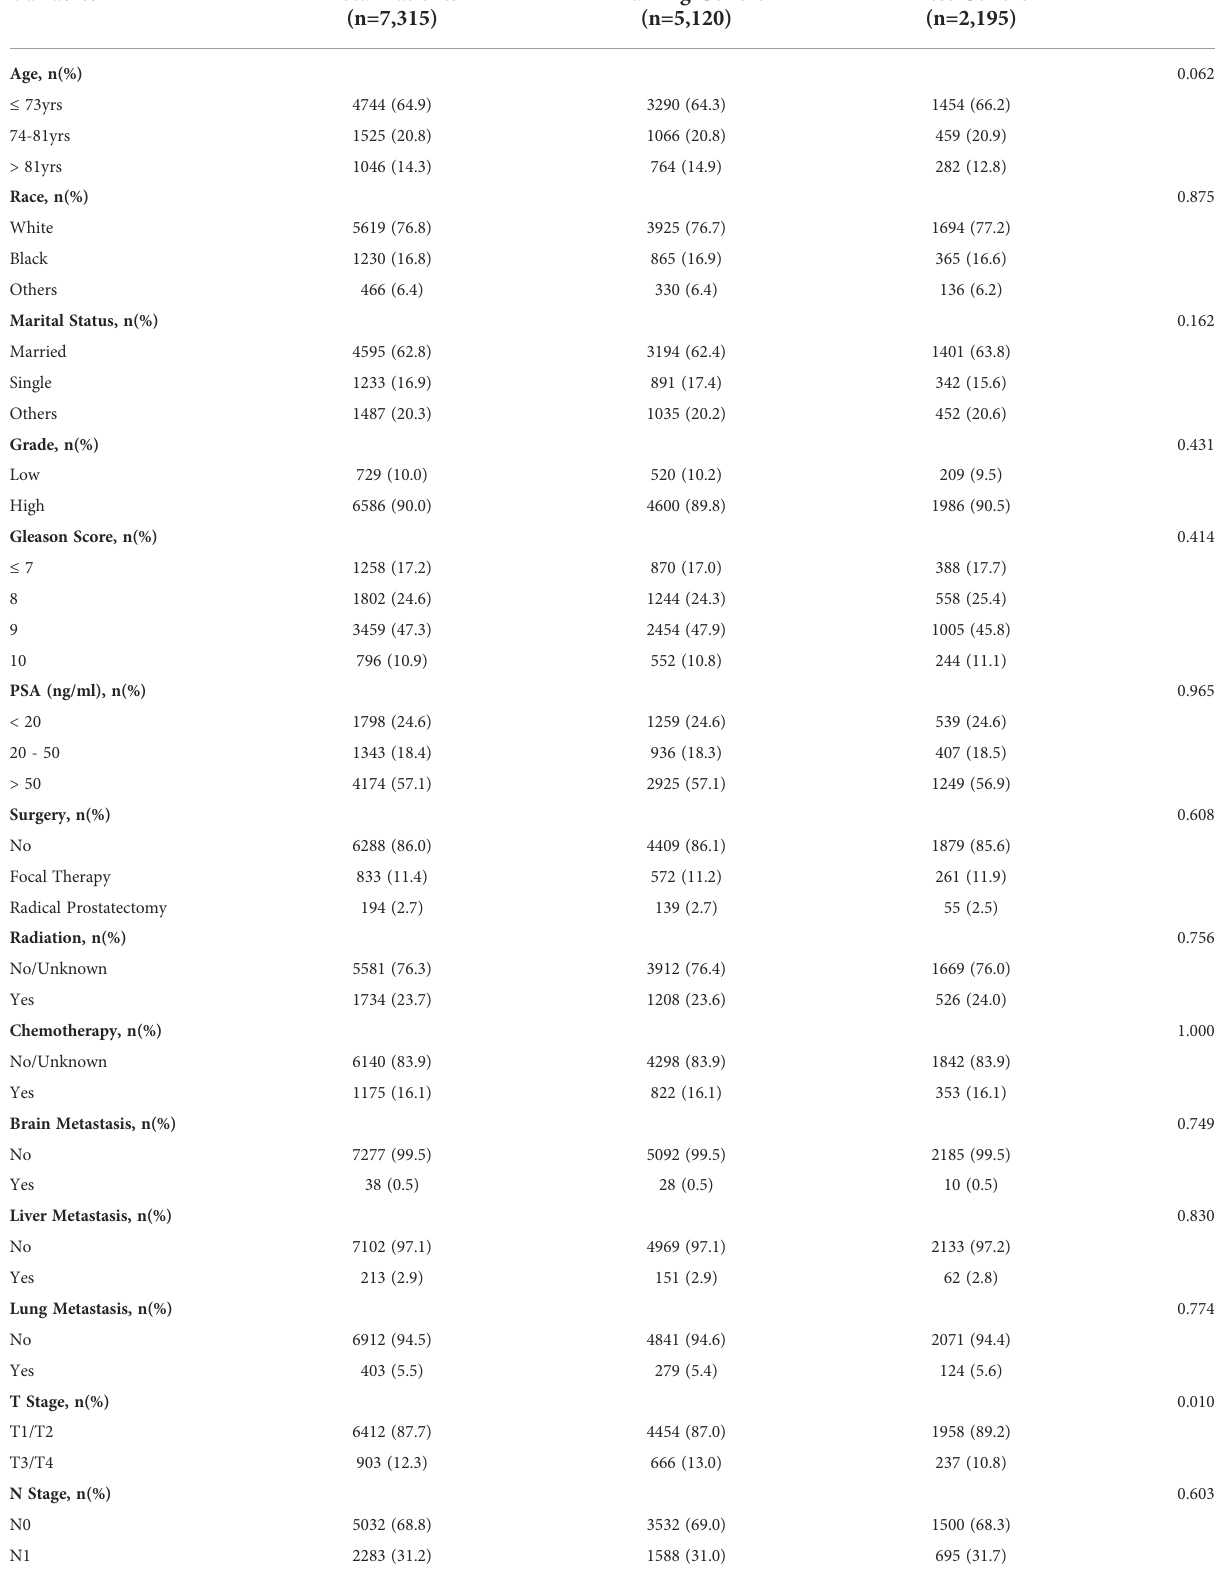
TABLE 1 Baseline characteristics of the 7,135 patients with bone metastatic prostate cancer between 2010 and 2016 from the SEER